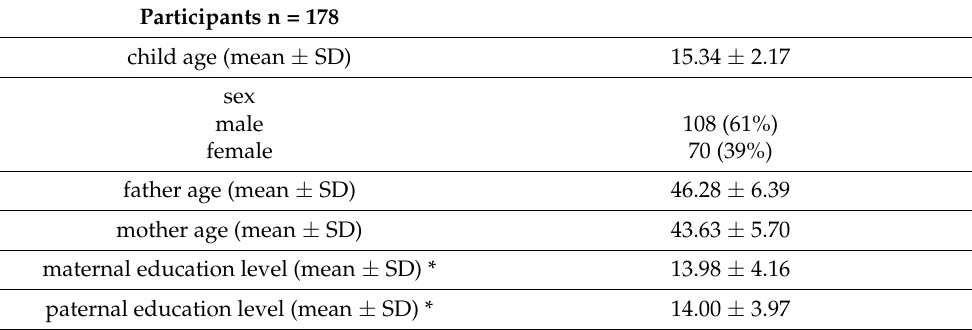
Table 1. Main socio-demographic feature of the total sample. SD = standard deviation. * calculated in years of education.